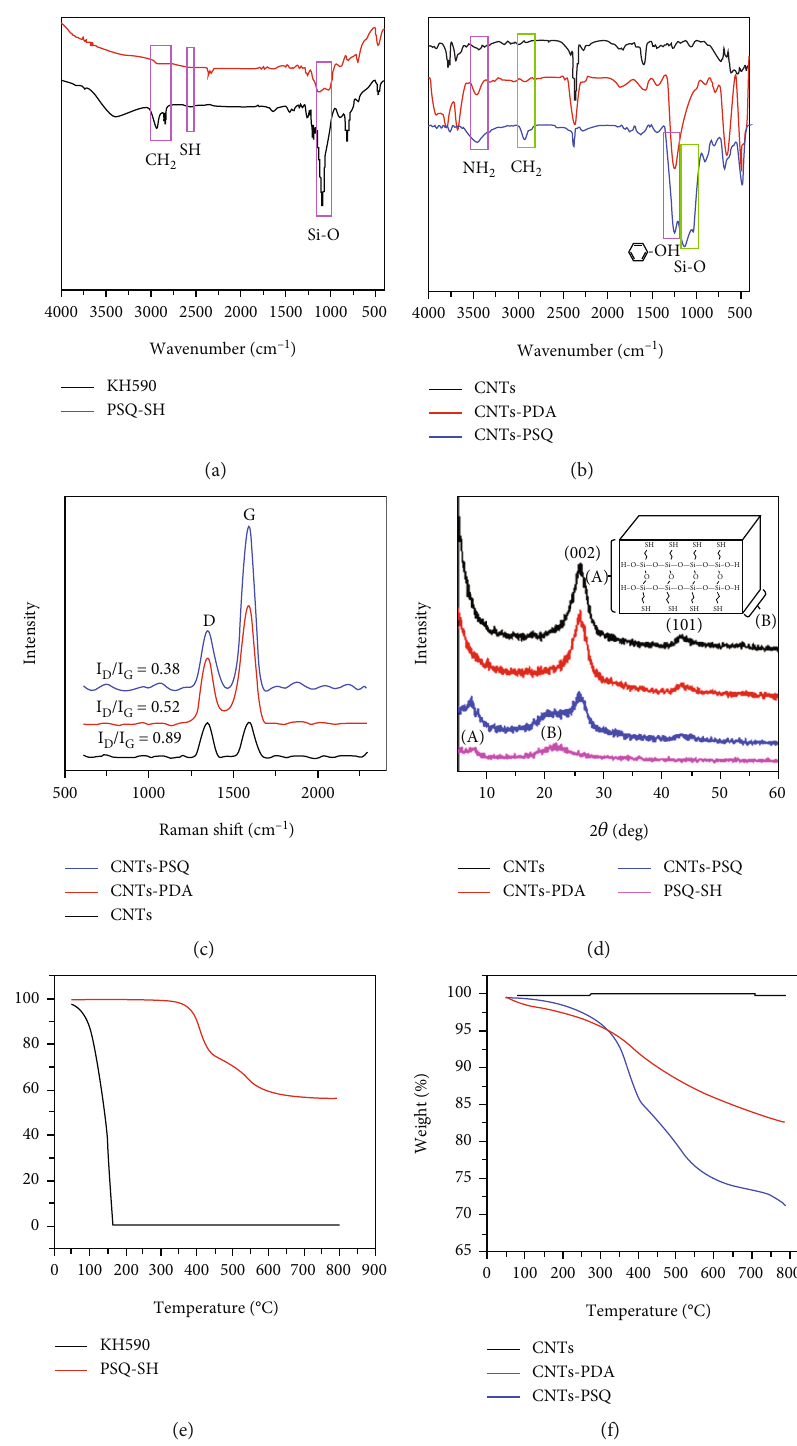
Figure 2: (a) FT-IR spectra of KH590 and PSQ-SH. (b) FT-IR spectra of pristine CNTs, CNTs-PDA, and CNTs-PSQ. (c) Raman spectra of pristine CNTs, CNTs-PDA, and CNTs-PSQ. (d) XRD spectra of PSQ-SH, pristine CNTs, CNTs-PDA, and CNTs-PSQ. (e) TGA diagrams of KH590 and PSQ-SH. (f) TGA diagrams of pristine CNTs, CNTs-PDA, and